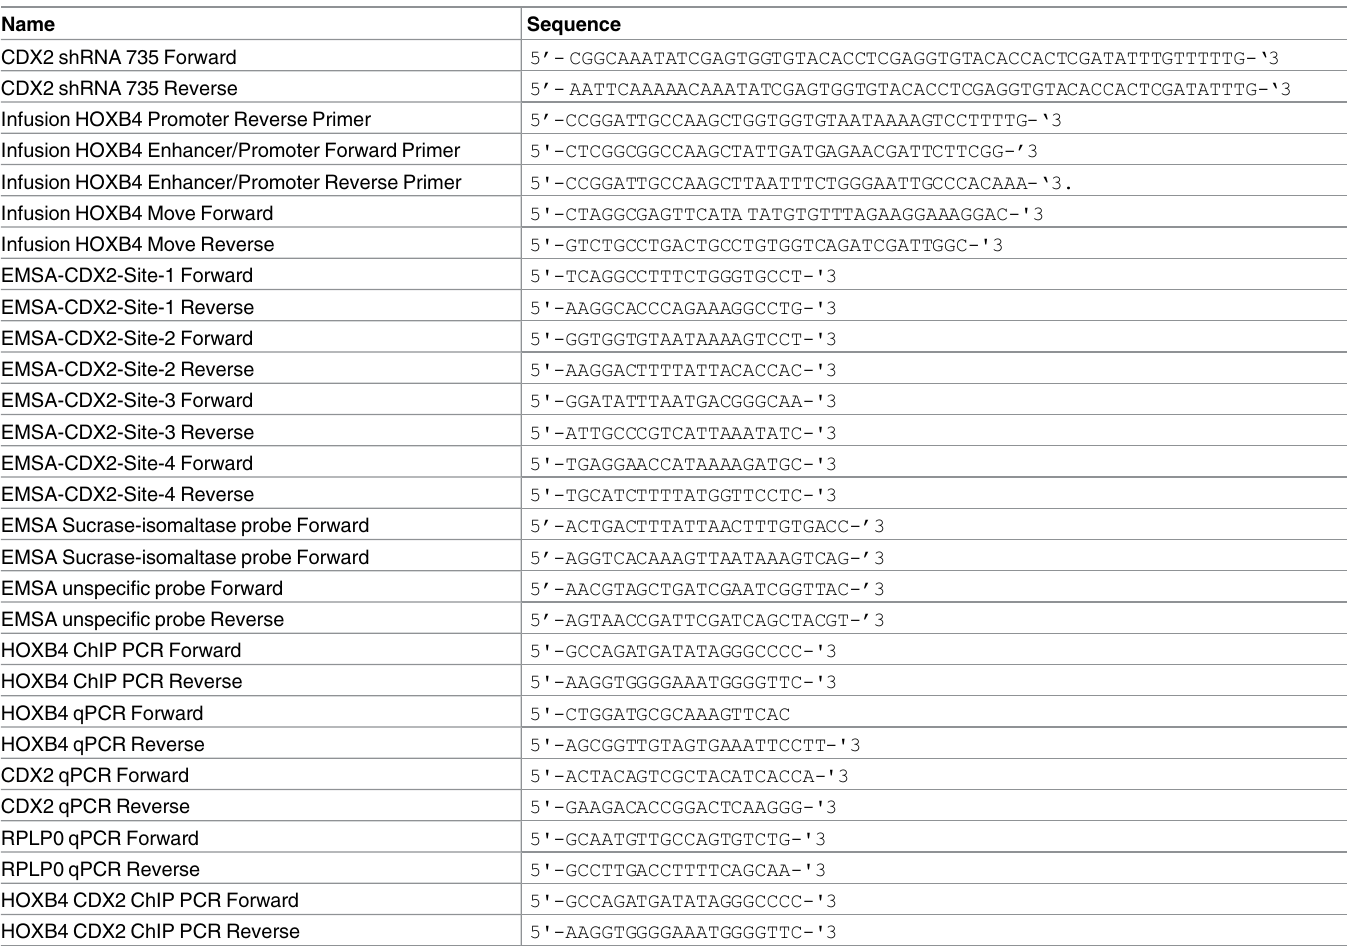
Table 1. DNA oligo sequences used in this